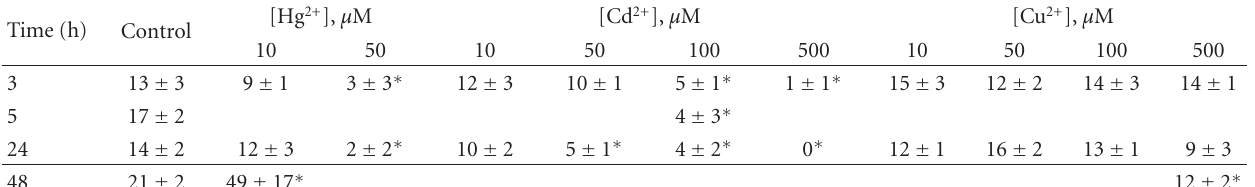
Table 2: Resting respiration rates (%) of PC12 cells after di ff erent time of incubation with increasing concentration of Hg 2+ , Cd 2+ , or Cu 2+ . Time